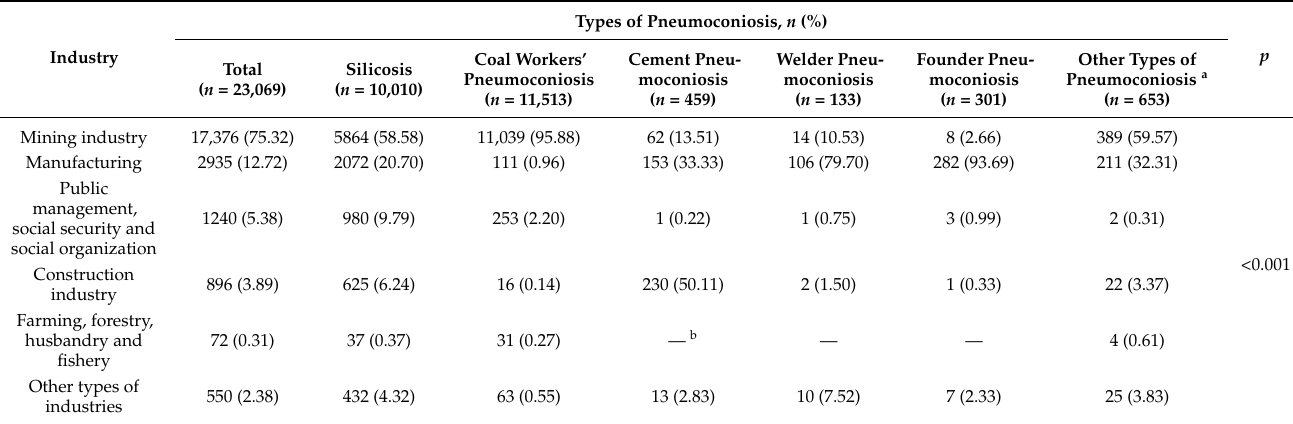
Table 2. Industry Distribution in Different Types of Pneumoconiosis